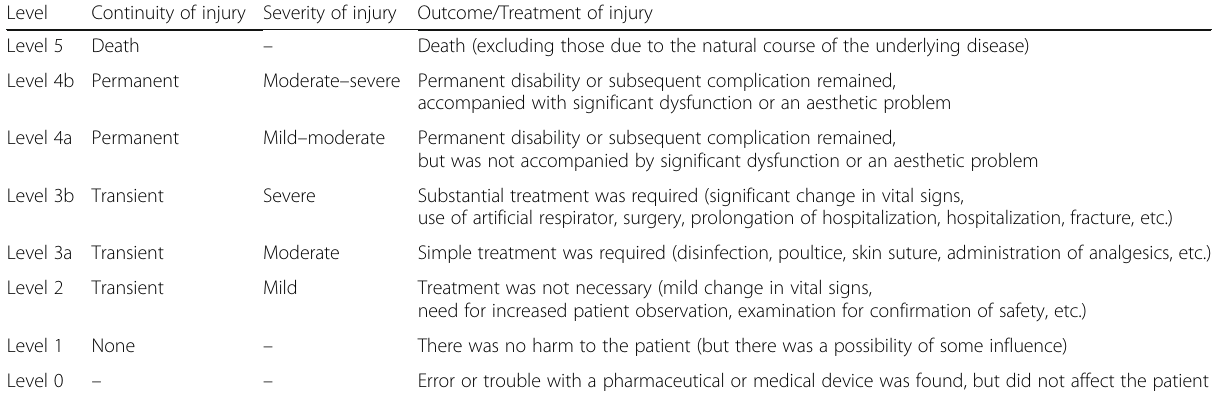
Table 1 Incident severity classification system recommended by the National University Hospital Council of Japan Level Continuity of injury Severity of injury Outcome/Treatment of